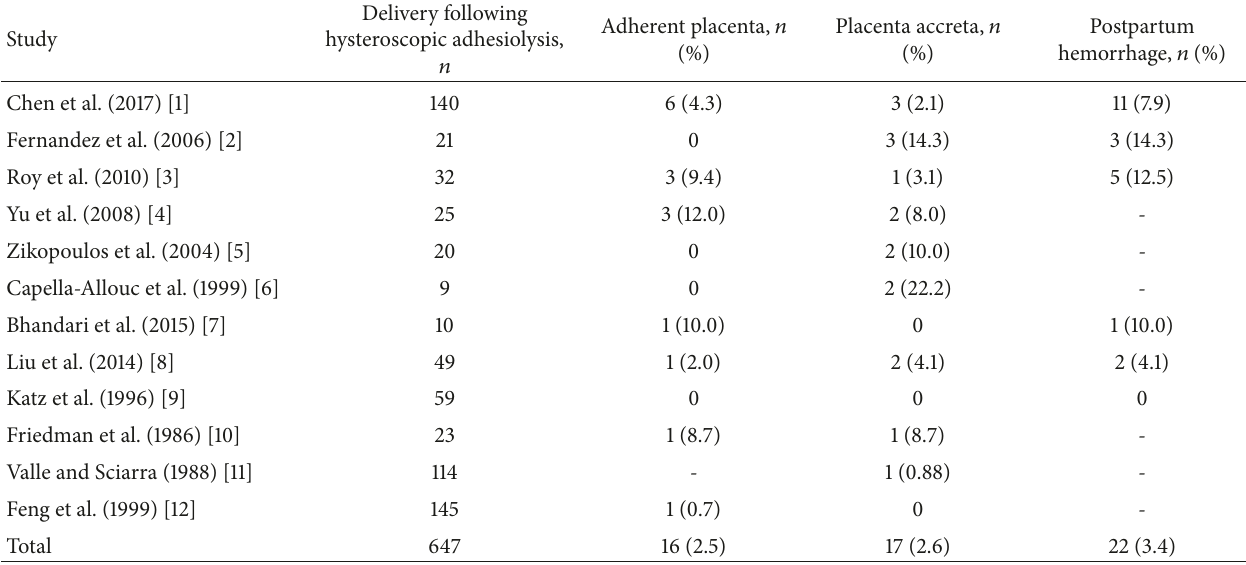
Table 1: Pregnancies after hysteroscopic